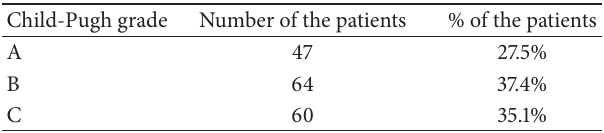
Table 2: Division of the patients in different groups as per Child- Pugh scoring